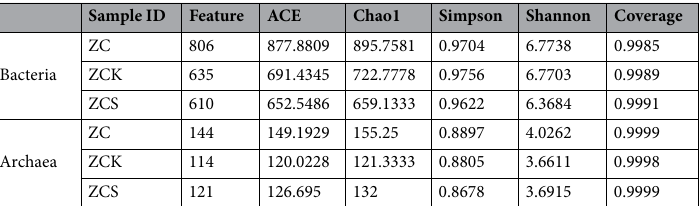
Table 3. Changes in biodiversity